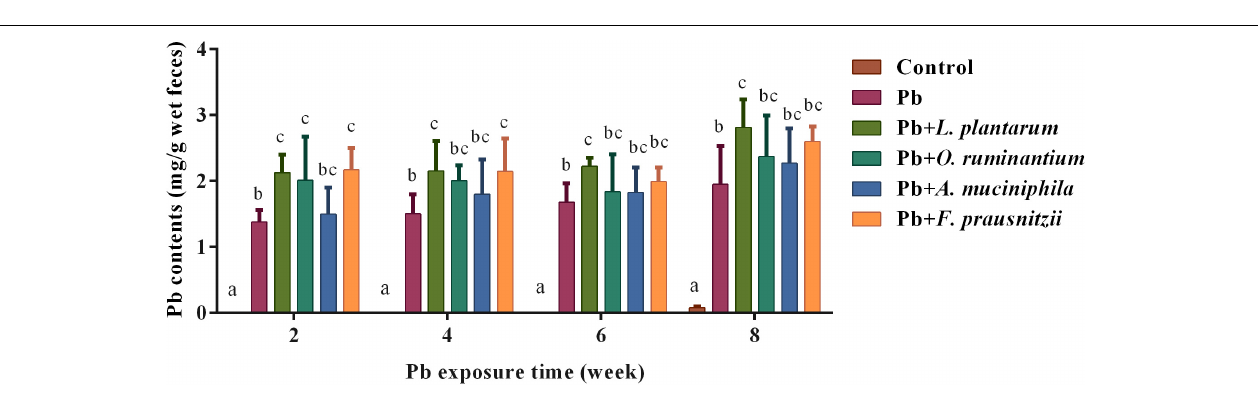
FIGURE 4 | The effects of Pb-intolerant gut microbes on fecal Pb levels in chronically Pb-exposed mice at different time points ( n = 6). Letters a–c denote statistically significant differences between each group ( p <